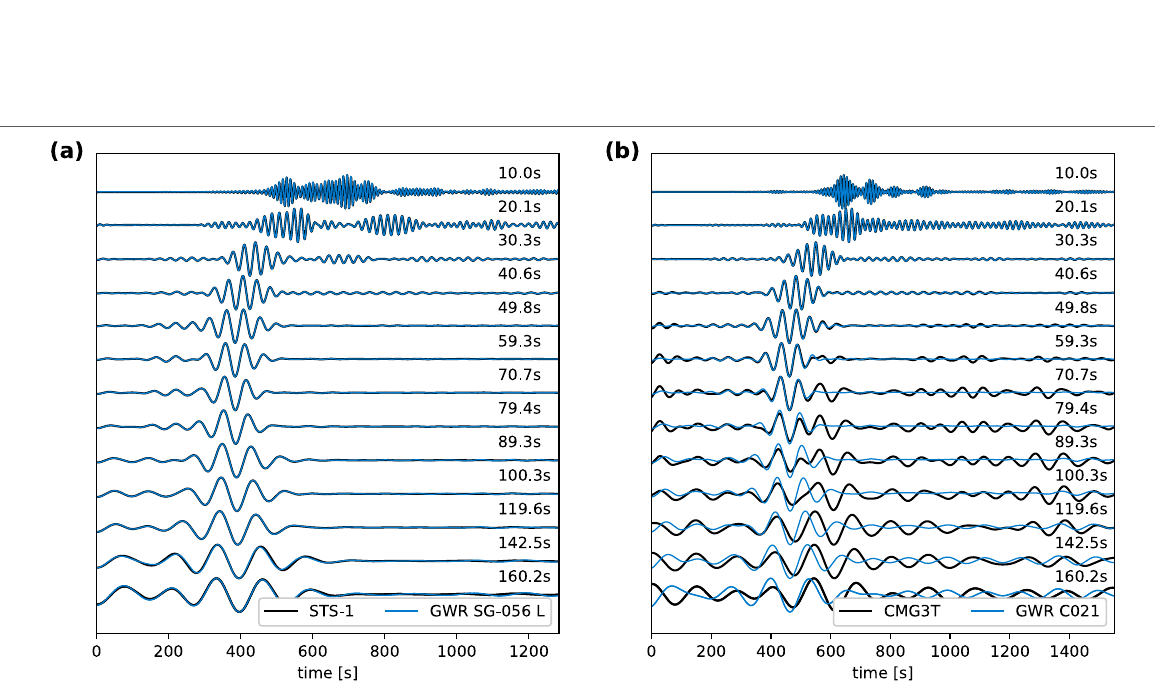
Fig. 3 Wave trains of the M5.4 Greece earthquake (2019‑02‑05 02:26:09.4 UTC, 39.02 ◦ N, 20.56 ◦ E, depth 10 km) recorded by the SG (blue lines) and the co‑located VBB and BB seismometers (black lines) of the Black Forest a and Membach b stations, respectively. Central periods are shown on the right for selected Gaussian